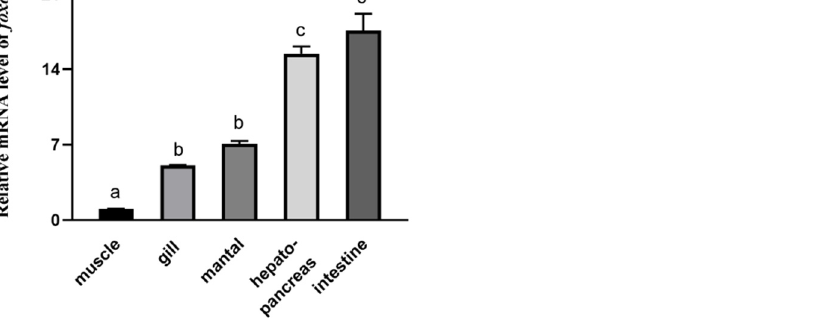
Figure 3. Tissues distribution of FoxO in abalone. Data are presented as means ± S.E., n = 6. Values with different letters are significantly different ( p < 0.05).